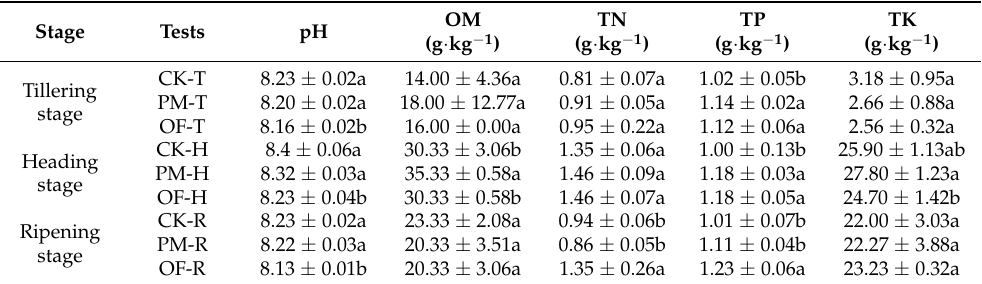
Table 2. Effects of manure application on the characteristics of paddy